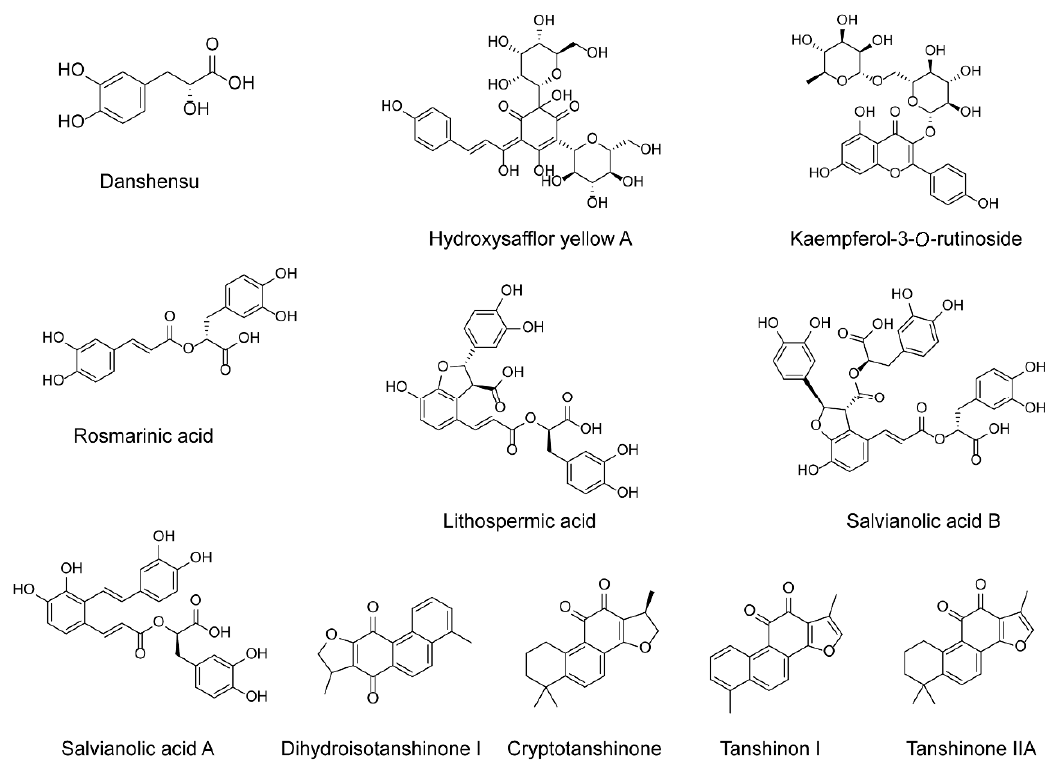
Figure 3. HPLC fingerprint of six proportions of the DH herbal pair. The chromatograms of S1–S6 represent the following: DH 5:1 (S1); DH 4:1 (S2); DH 3:1 (S3); DH 2:1 (S4); DH 1:1 (S5); DH 1:2 (S6).